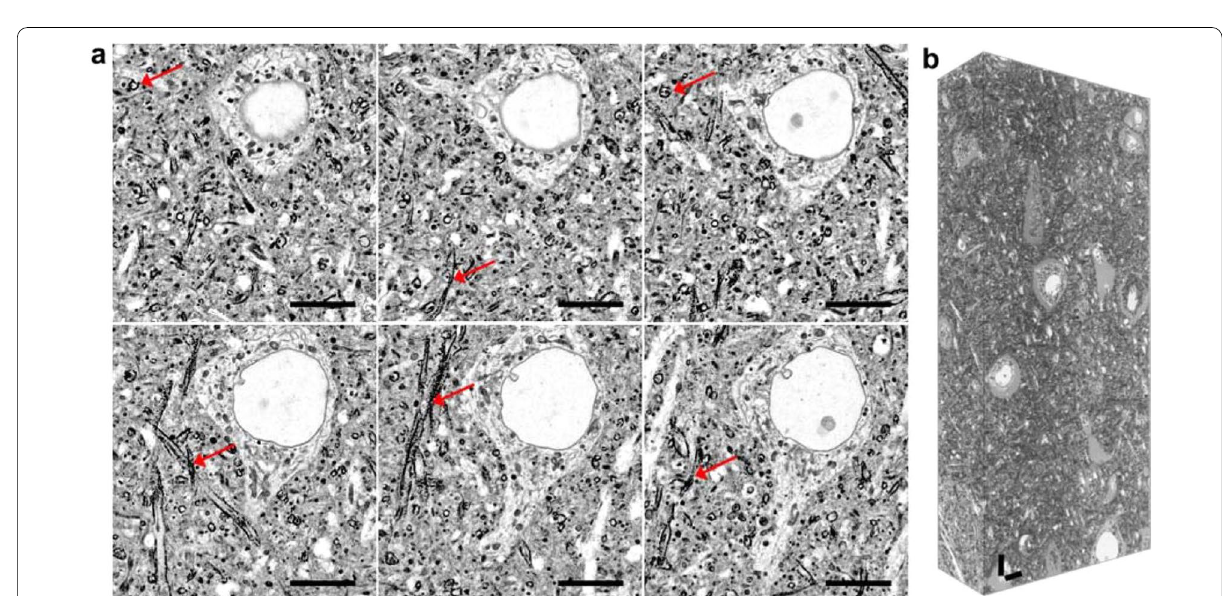
Fig. 11 Membrane expansion microscopy (mExM) of fixed brain tissue. a Six serial sections from a 3D image stack obtained on a confocal spinning-disk microscope. Axons can be identified by their high contrast due to the increased concentration of lipids in the myelin sheaths (red arrows). Scale bar, 10 μm. b mExM processed tissue imaged with light-sheet microscopy. Scale bar, 10 μm. (Reprinted/adapted from